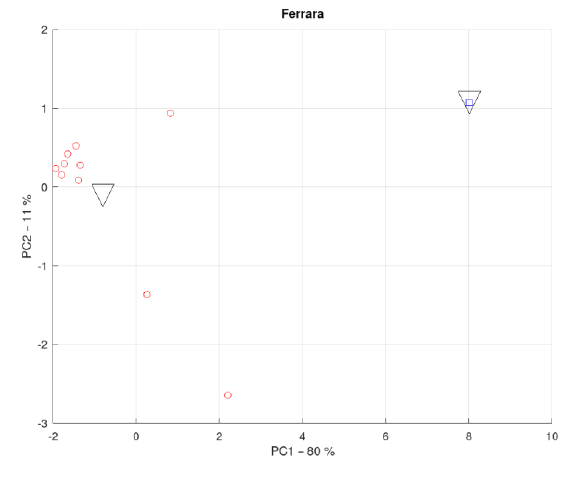
Figure 3. District of Ferrara 2D-Score plot showing PC1 vs. PC2 with clusters highlighted: first cluster in red and the second cluster in blue.